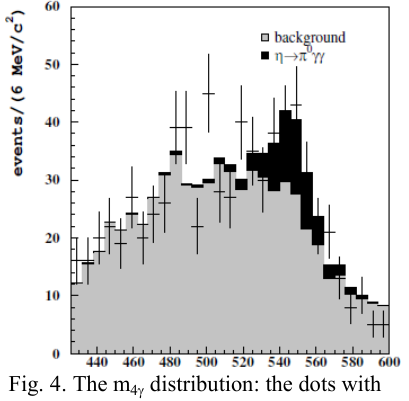
Fig. 4. The m 4  distribution: the dots with error bars show the data; simulated signal and backgrounds are normalized according to the fit